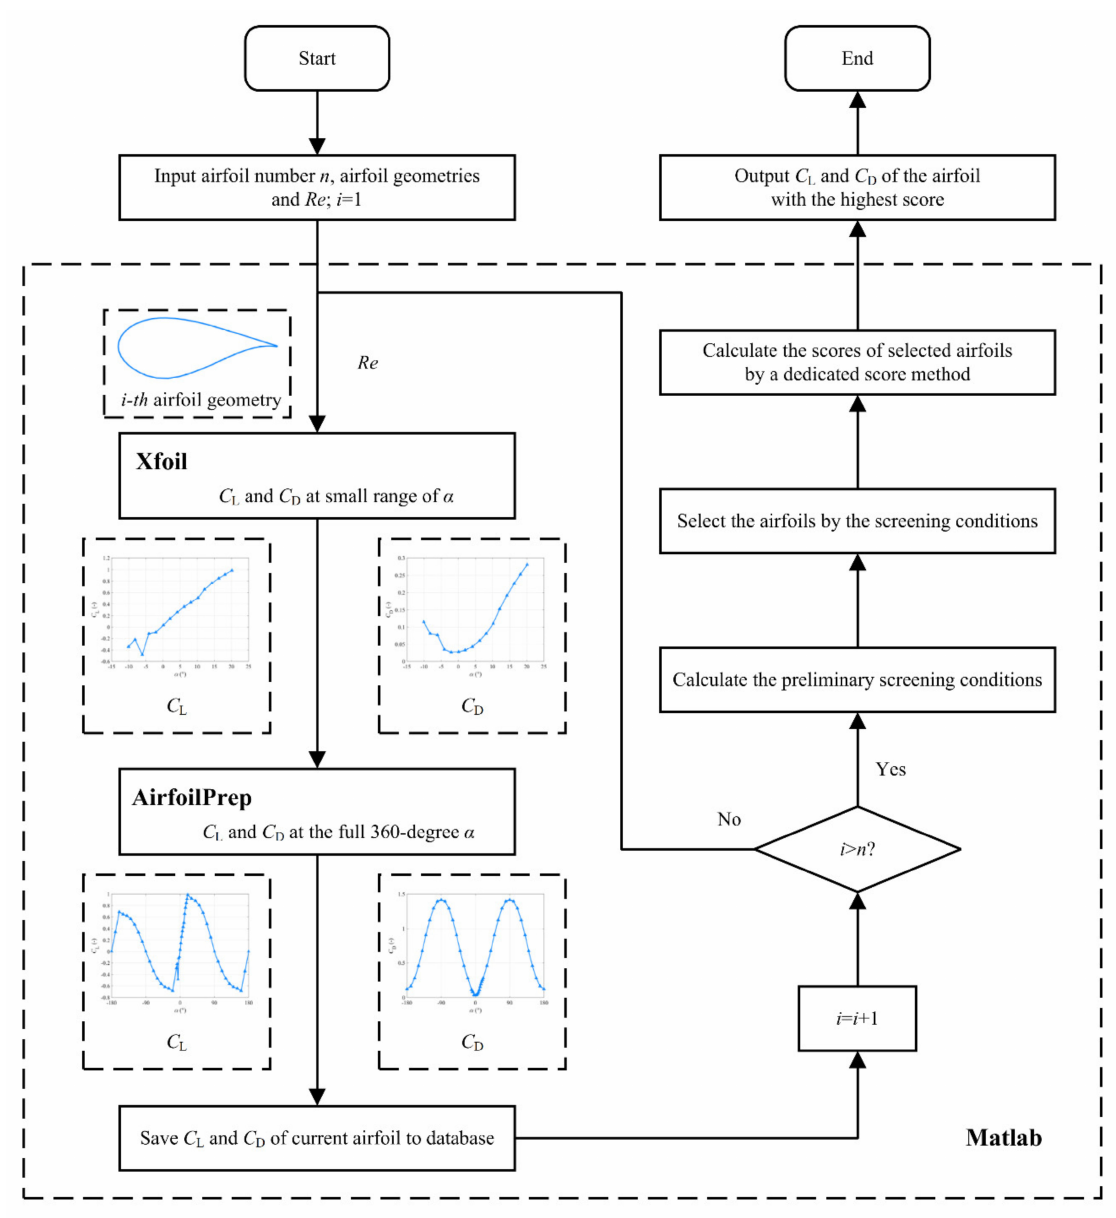
Figure 2. The flow-chart of XAM